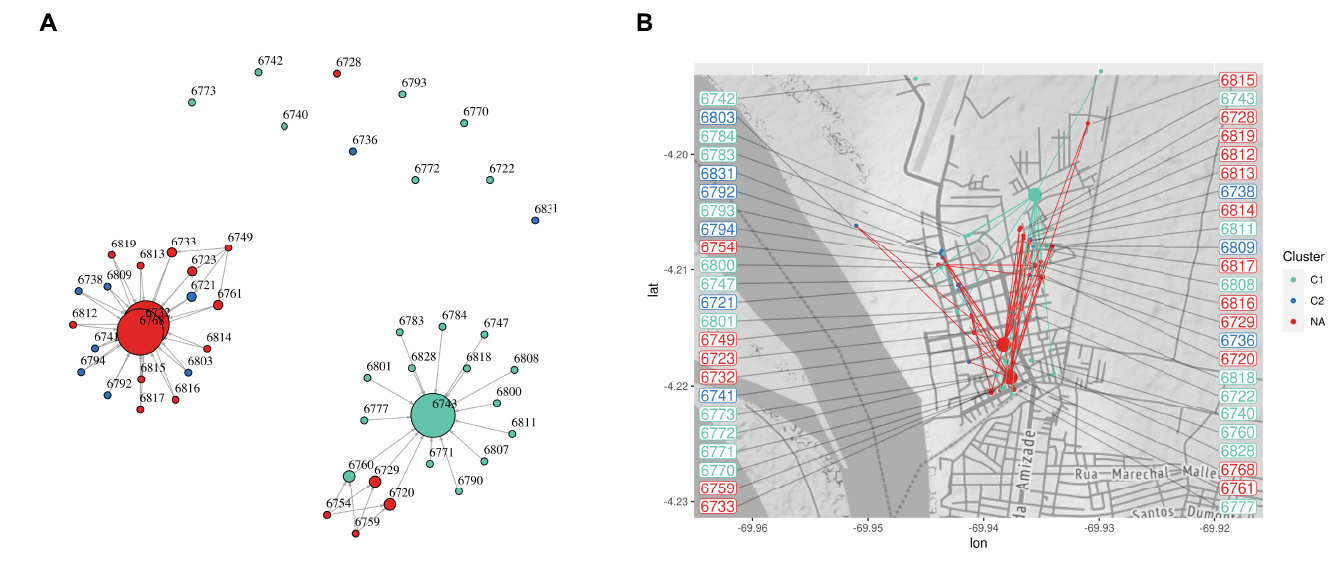
Fig 4. SARS-CoV-2 Spatial-temporal analyses A. Point intersection network of interconnected clusters of isolates within distinct clusters. Size of vertices are proportional to number of isolates. Color of points reflect clusters that correspond with C1 (cyan), C2 (blue) or not (red). B. Spatial projection of the point intersection network over the streets of Leticia,